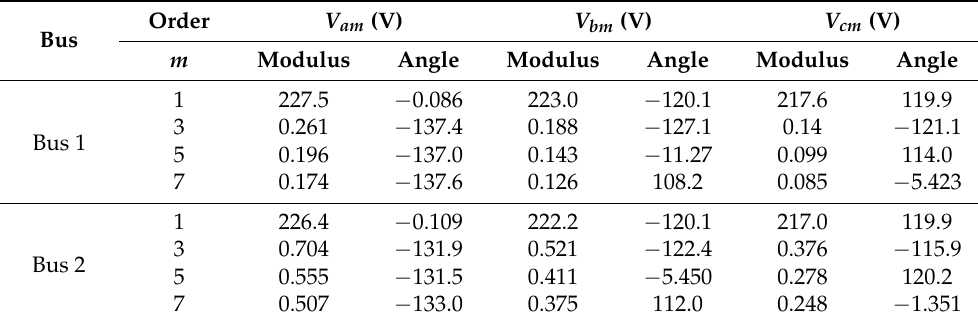
Table 2. Harmonic line-to-neutral voltage.